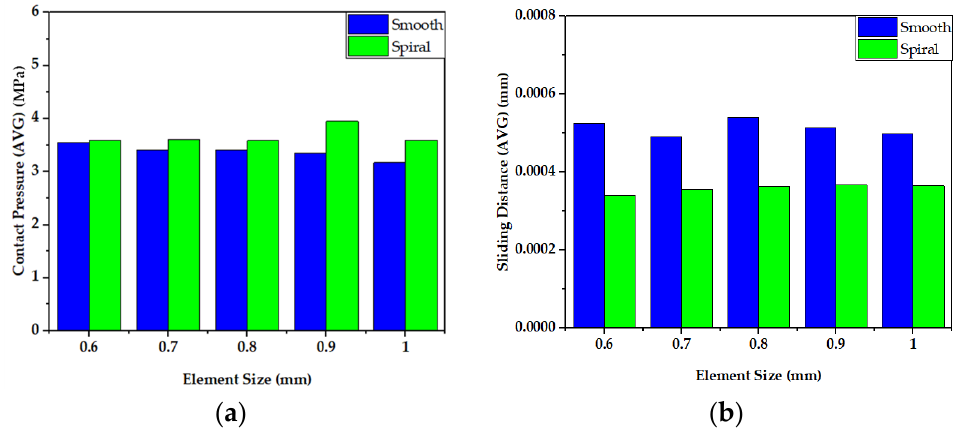
Figure 6. Impact of mesh element size variation on ( a ) average contact pressure and ( b ) average sliding distance for both head-stem trunnion types.